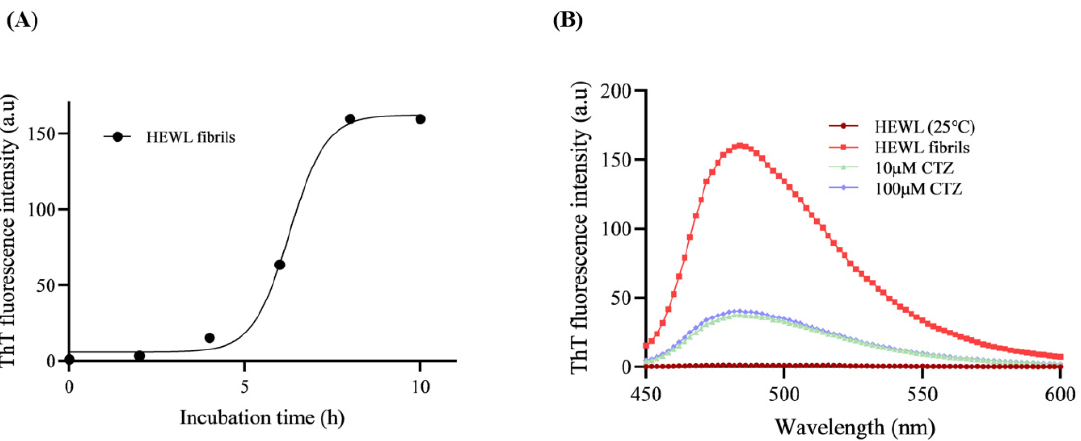
Figure 4. The effect of CTZ toward HEWL fibrillation measured by ThT fluorescence assay. ( A ) ThT fluorescence intensities of 10 µM HEWL monitored at different time points during incubation period. ( B ) ThT fluorescence intansity of 10 µM HEWL in the presence and absence of 10 µM and 100 µM CTZ after 8 hrs incubation.